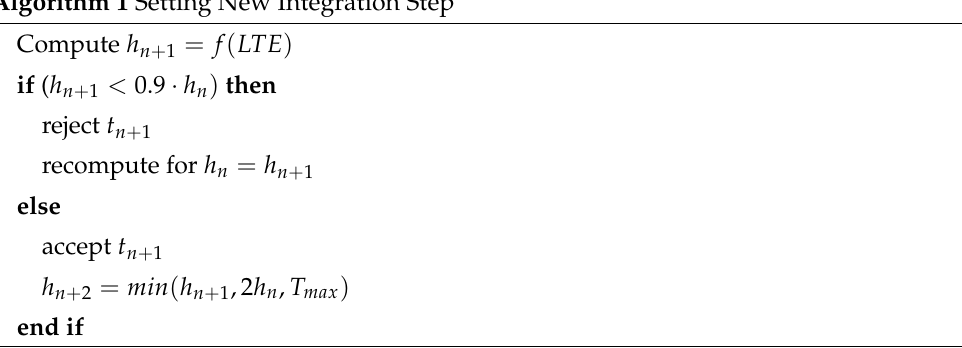
Algorithm 1 Setting New Integration